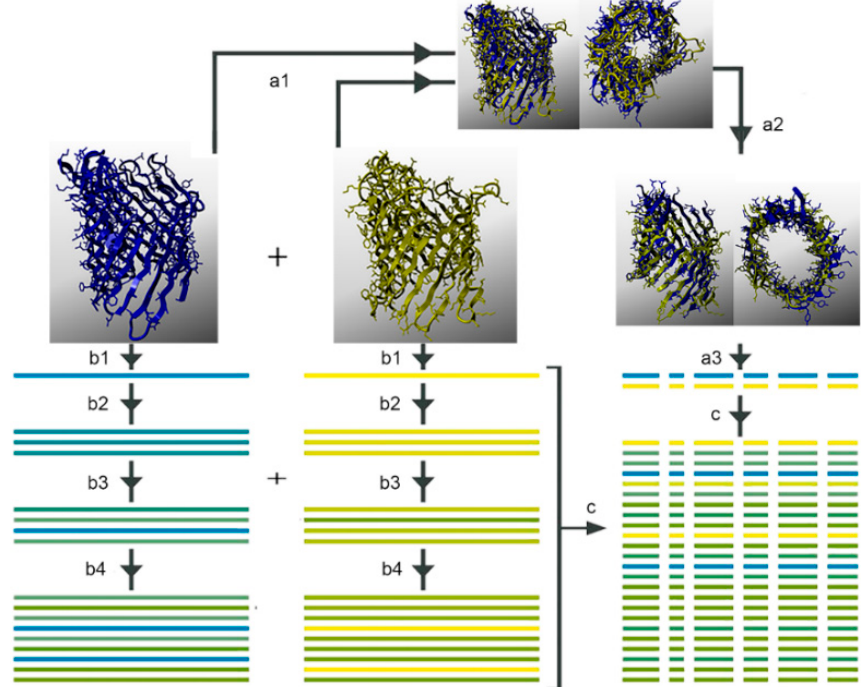
Figure 10. The sequence analysis workflow [102] (copied with permission from Bio-Prodict) shows the process of structure superposition guided by a profile alignment of the sequences. Step a1 shows the superposition of two structures (Omp32, colored blue, and PhoE in yellow; PDB IDs: 2FGQ and 1PHO, respectively); Step a2 shows the core alignment of the barrel structures in which loops have been removed; Step a3 is core alignment of similar structure; Step b is a sequence alignment against the nearest structure. All sequences and structures from one subclass are aligned together in step c. Both structures used in this MSA (multiple sequence alignment) belong to the general diffusion protein subclass. The WHAT IF module of the YASARA/WHAT IF twinset was used for these analyses [39].